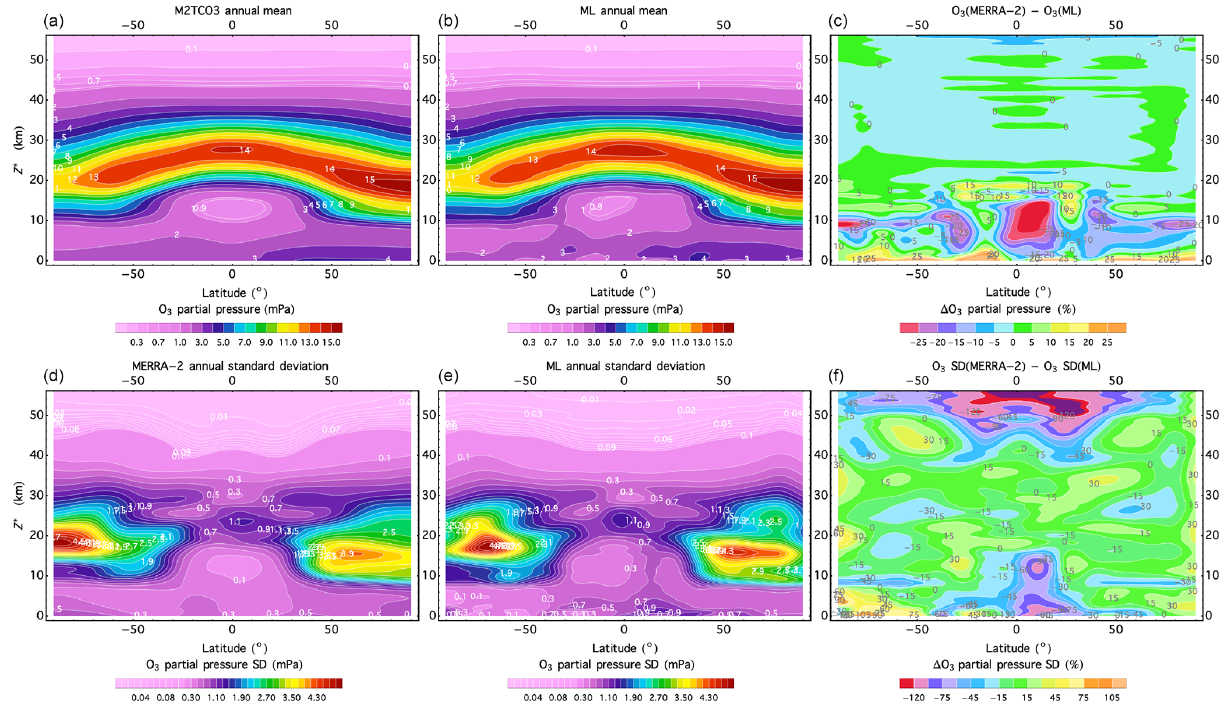
Figure 14. Annual zonal mean profiles and standard deviations from M2TCO3 and ML climatologies and their differences. (a, b, c) Latitude- dependent O 3 partial pressure (mPa) profiles: M2TCO3 (a) , ML (b) , and their relative differences (c) . (d, e, f) Latitude-dependent O 3 profile standard deviations (mPa): M2TCO3 (a) , ML (b) , and their percent differences (c)